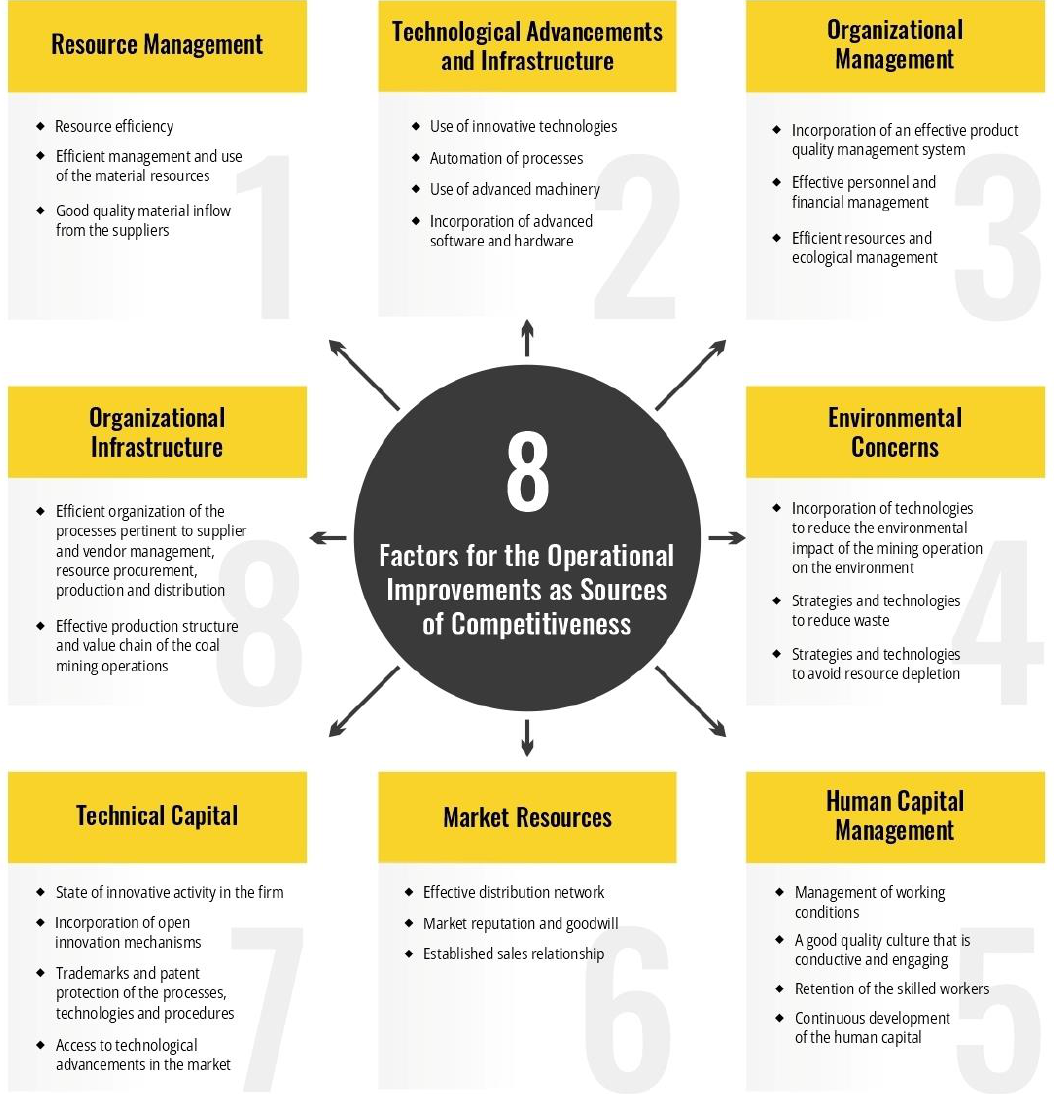
Figure 5. Factors for the enterprise competitiveness assessment and management (developed by the